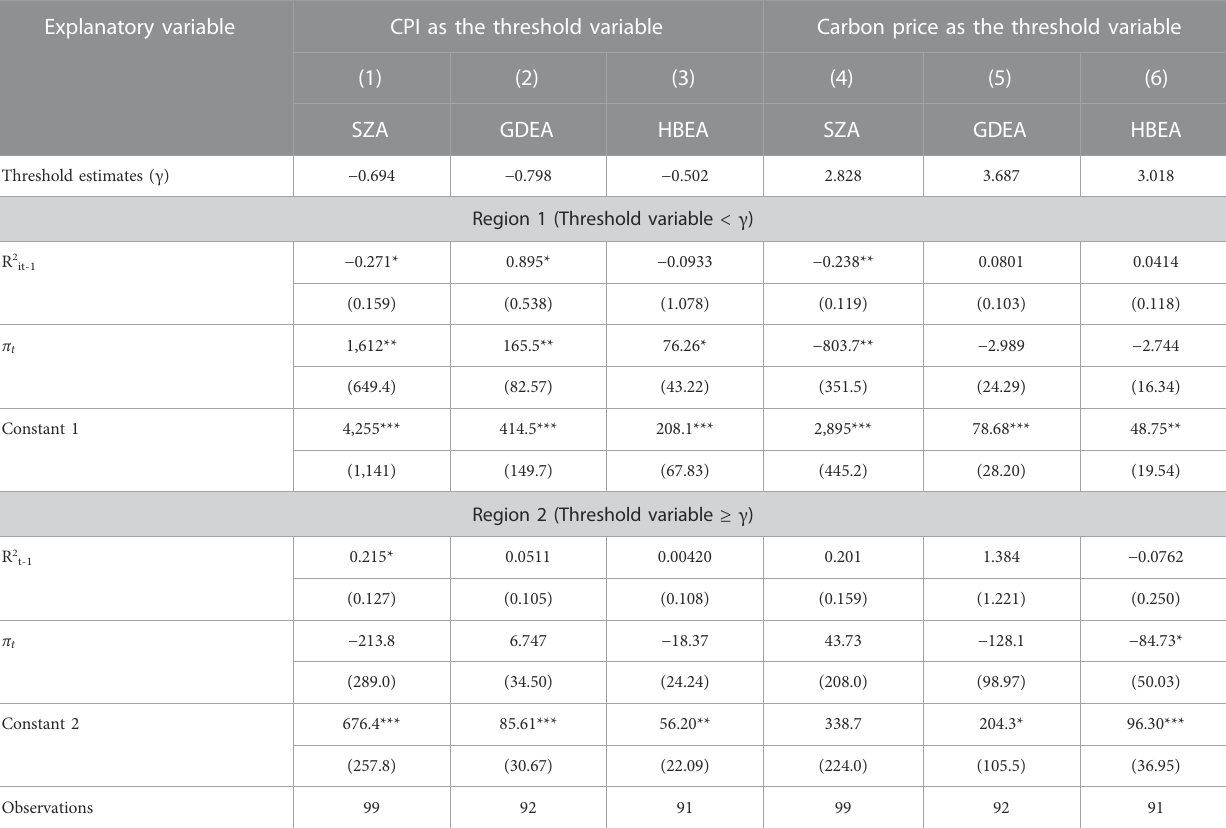
TABLE 7 Regression results of carbon price growth rate squared and in fl ation rate threshold. Explanatory variable CPI as the threshold